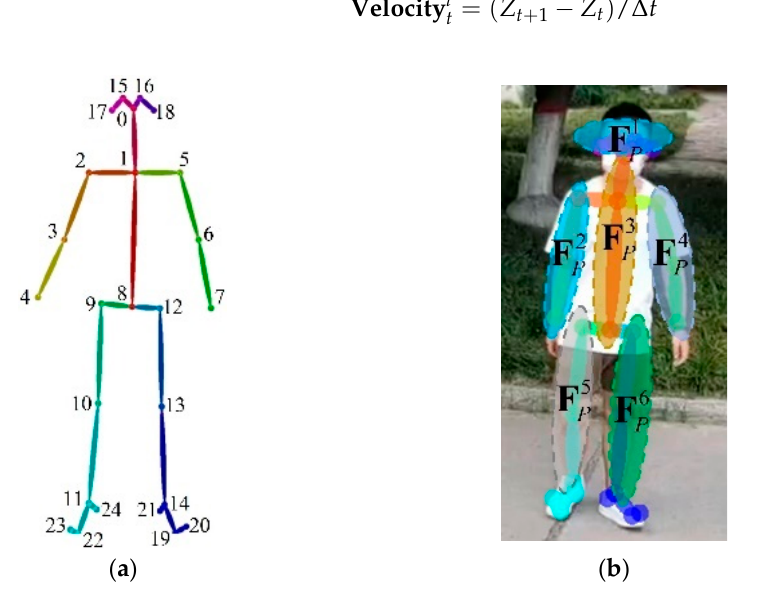
Figure 6. Schematic diagram of pedestrian 3D pose feature selection: ( a ) Openpose-Body25 model and ( b ) body joint classification